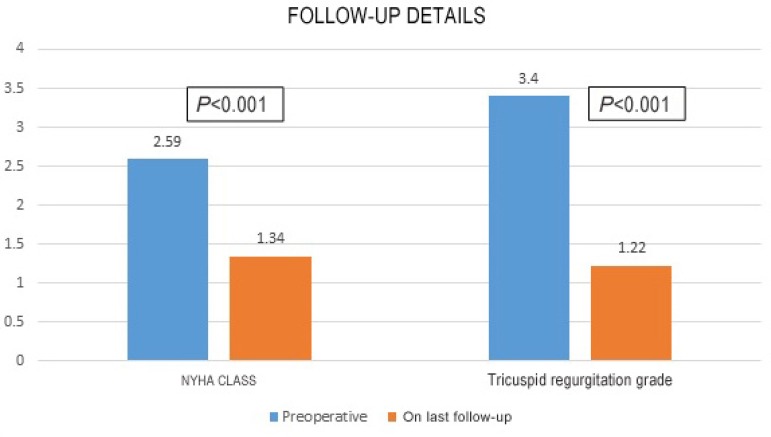
Comparison of pre- and postoperative data (follow-up).